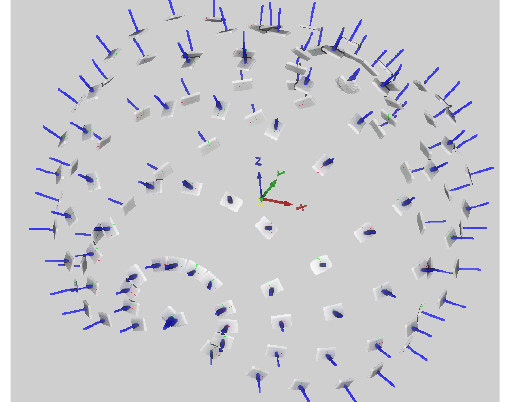
Figure 11: Examples of camera network obtained using multiple shots after tilting the object around the Y axes.